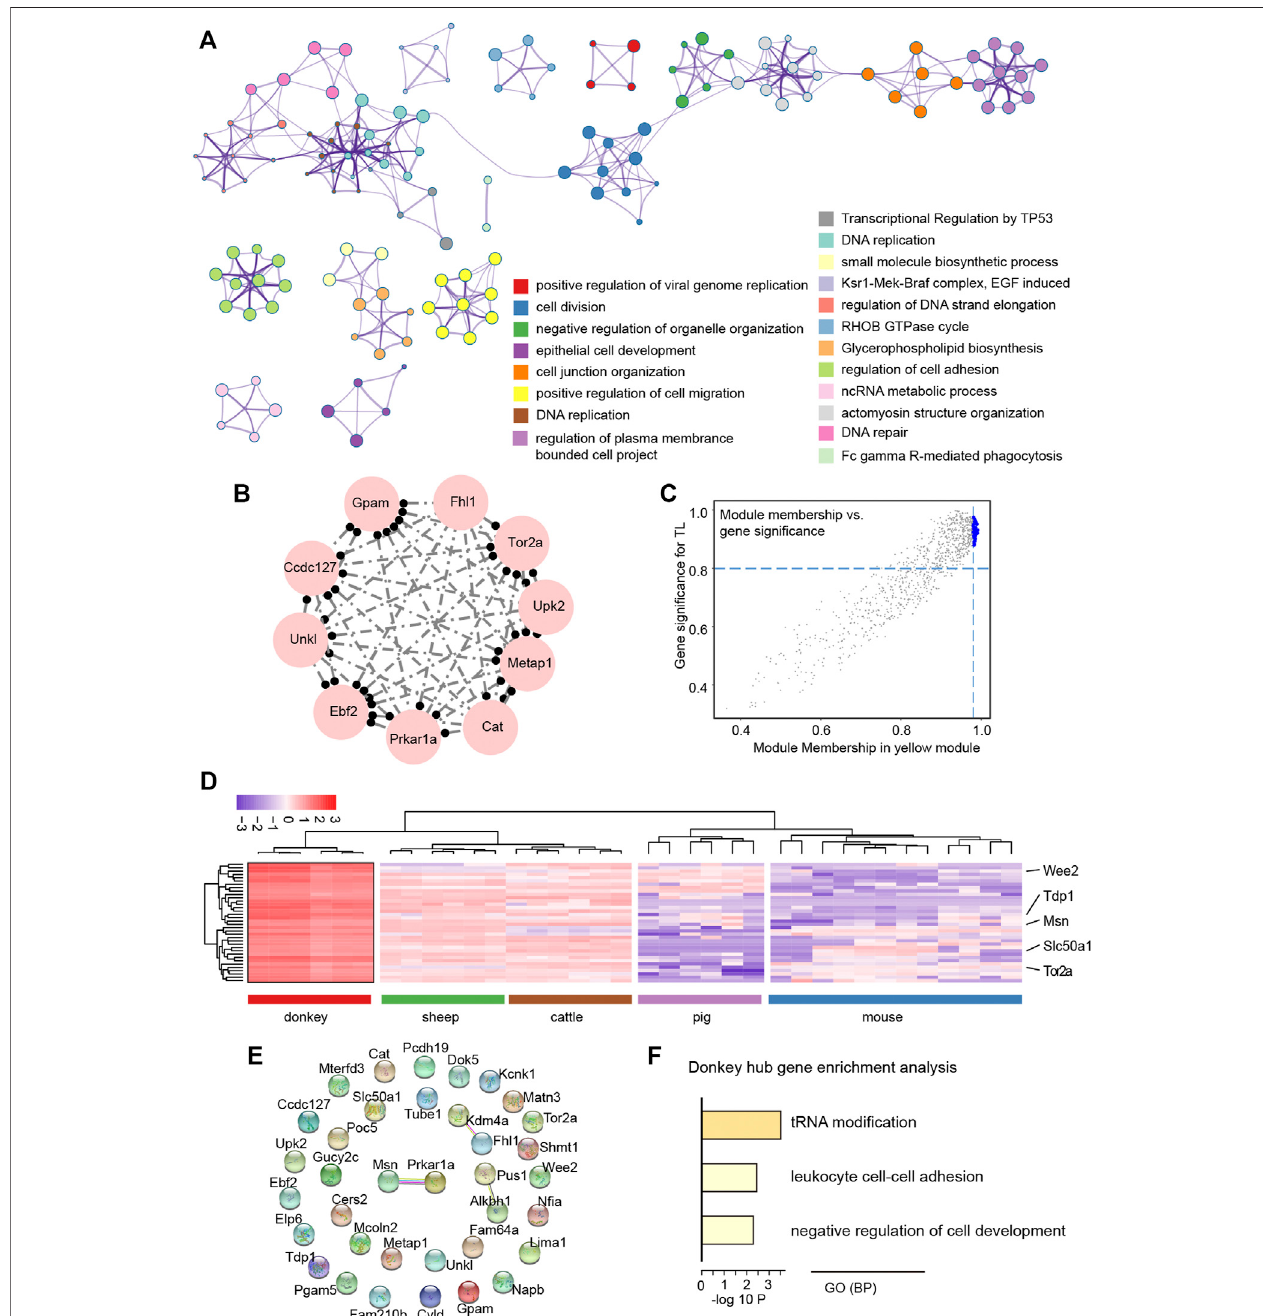
FIGURE6| Functionalexplorationofhubgenesrelated todonkey oocytedevelopmentidenti fi edbyweightedgeneco-expression networkanalysis(WGCNA). (A) The GO and KEGG annotation of genes in the yellow functional module. (B) The top 10 topological overlap relationship in the yellow functional module. (C) The scatter plot shows the relationship between module membership and gene signi fi cance (MM & GS). The large blue dots represent hub genes related to donkey oocyte development. (D) The heat map shows the expression levels of hub genes selected by the yellow functional module. (E) The protein-protein interaction network of hub genes. The connection between proteins represents the degree of protein interaction. (F) The GO (biological process) terms of hub genes related to donkey oocyte development.